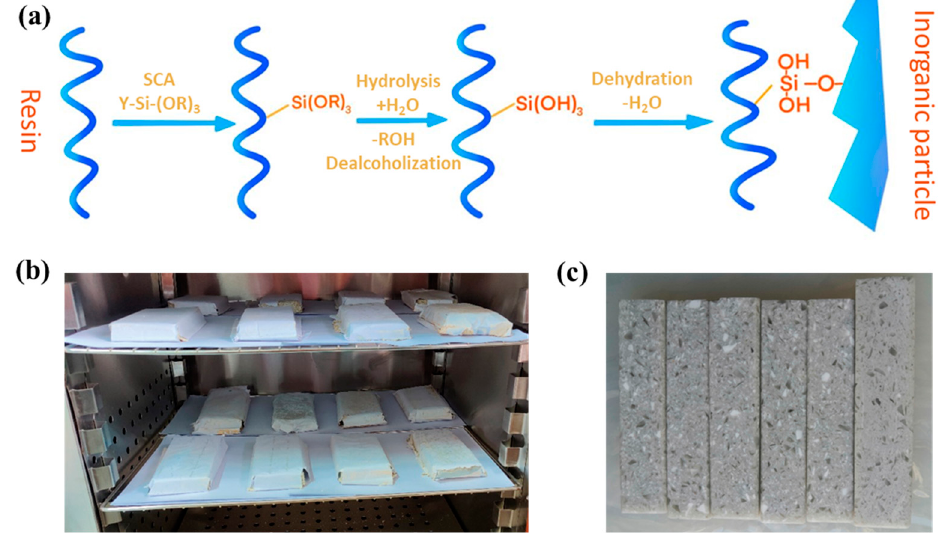
Figure 2. ( a ) Schematic diagram of the curing process between ceramic particles and resin, and arti- ficial stone samples subjected to ( b ) thermocuring and ( c ) polishing and cutting. artificial stone samples subjected to ( b ) thermocuring and ( c ) polishing and